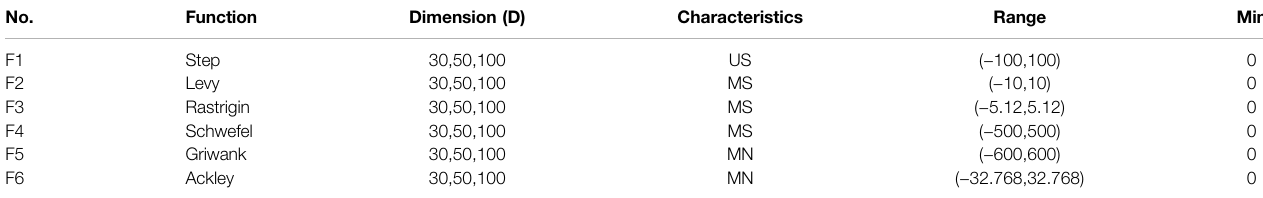
TABLE 3 | The basic information of the six benchmark functions. No.